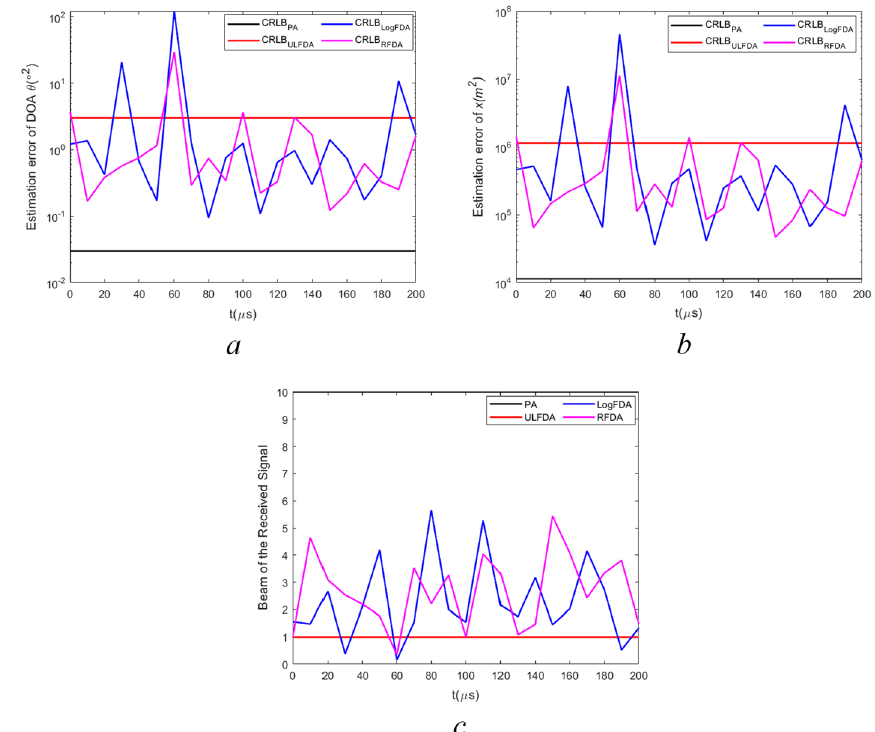
Fig. 10 CRLB and Beampattern with t . a DOA CRLB, b Location CRLB, and c